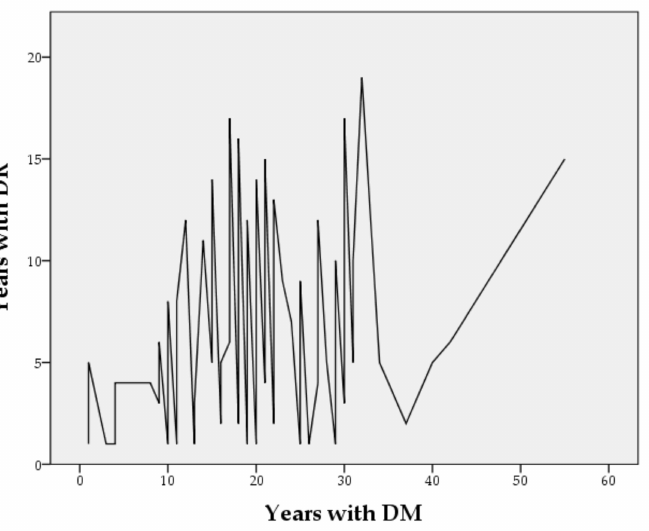
Figure 1. Years since the diagnosis of DM and the moment of appearance of DR in the study